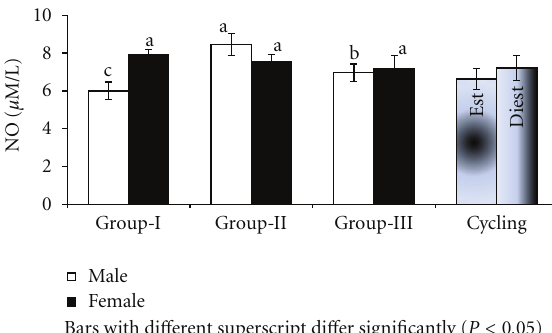
Figure 6: NO in culture supernatant supplemented with testos- terone in Murrah bu ff aloes of di ff erent sex, age, and stage of